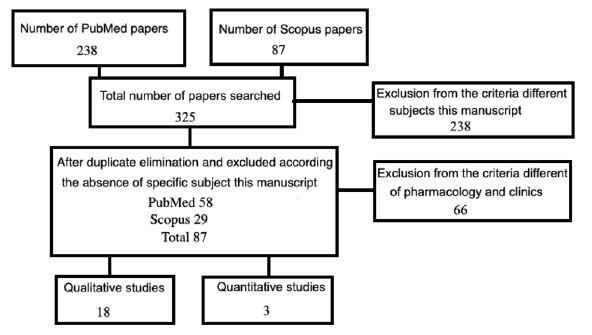
Figure 1. Flowchart of papers selected for this